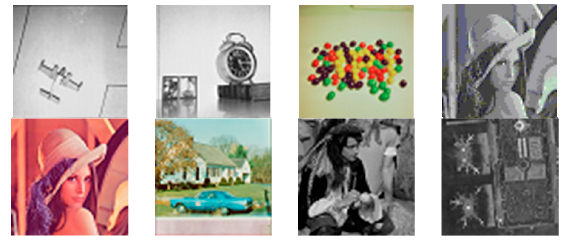
Figure 11. Group 1 images.